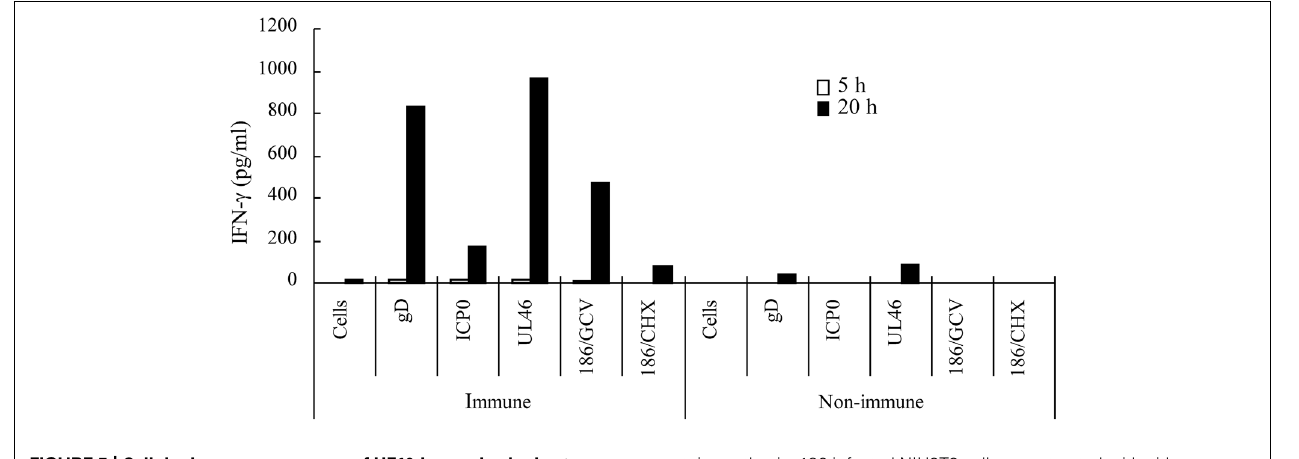
FIGURE 5 | Cellular immune responses of HF10-immunized mice to HSV-2 proteins. Splenocytes (1 × 10 6 cells) from HF10-immunized or unimmunized mice were collected and incubated at 37 ◦ C for 3 h. NIH3T3 cells (1 × 10 6 cells) transfected with expression vectors for HSV-2 gD, ICP0, and UL46 were added into dishes to stimulate splenocytes.To confirm